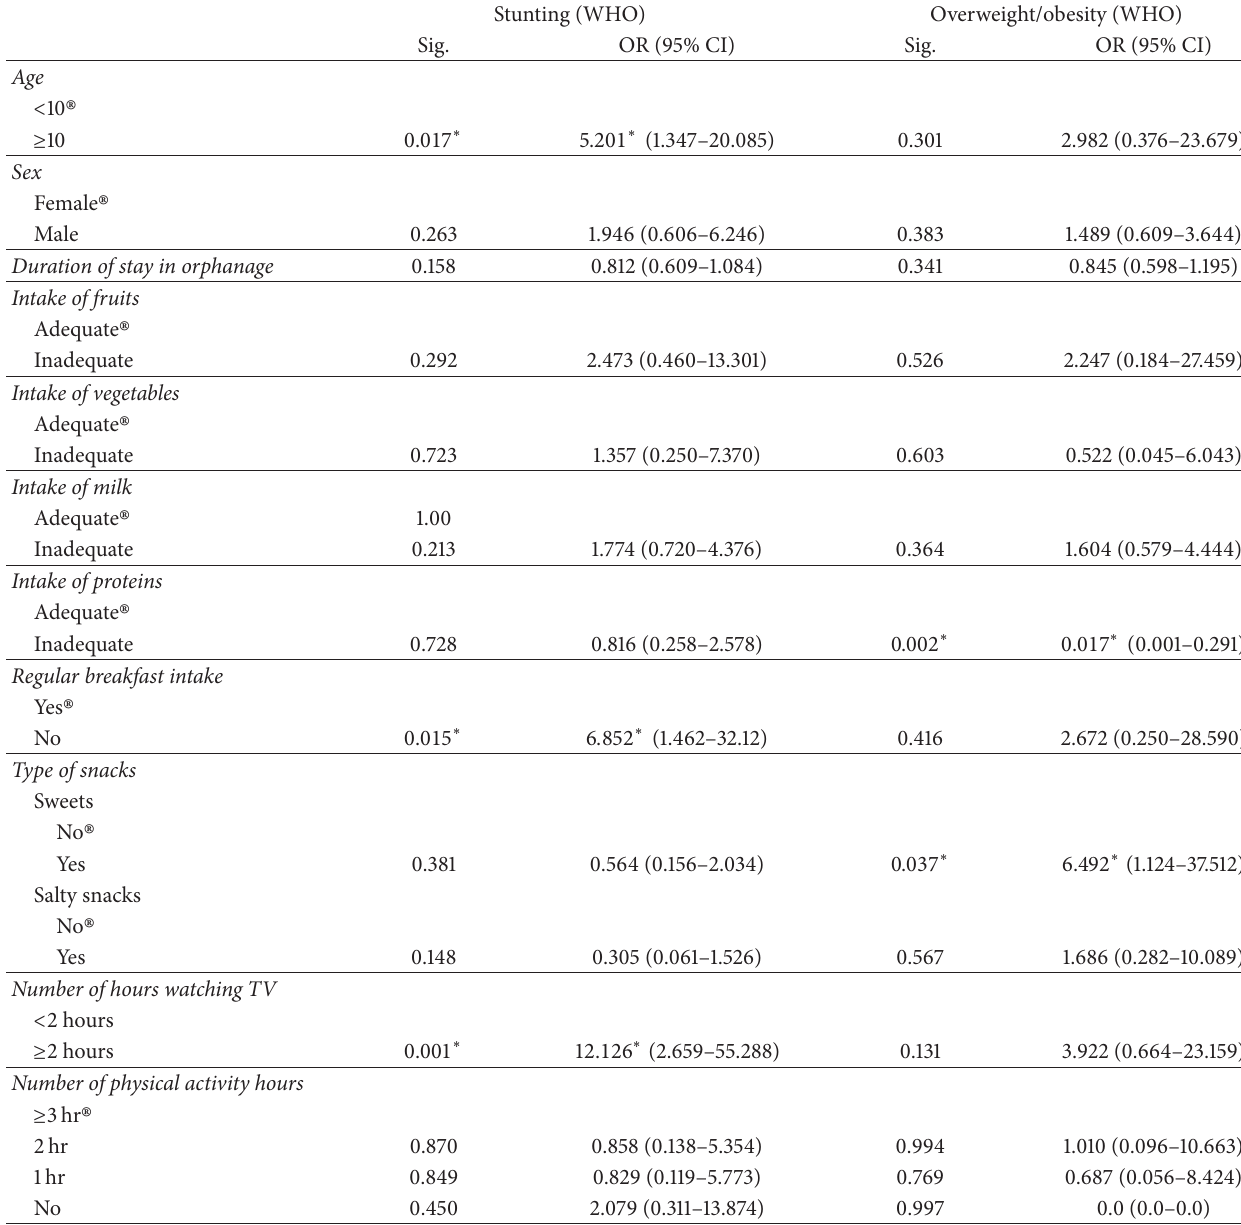
Table 5: Association between stunting or overweight/obesity and demographic, dietary, and lifestyle behaviors among children and adolescents residing in